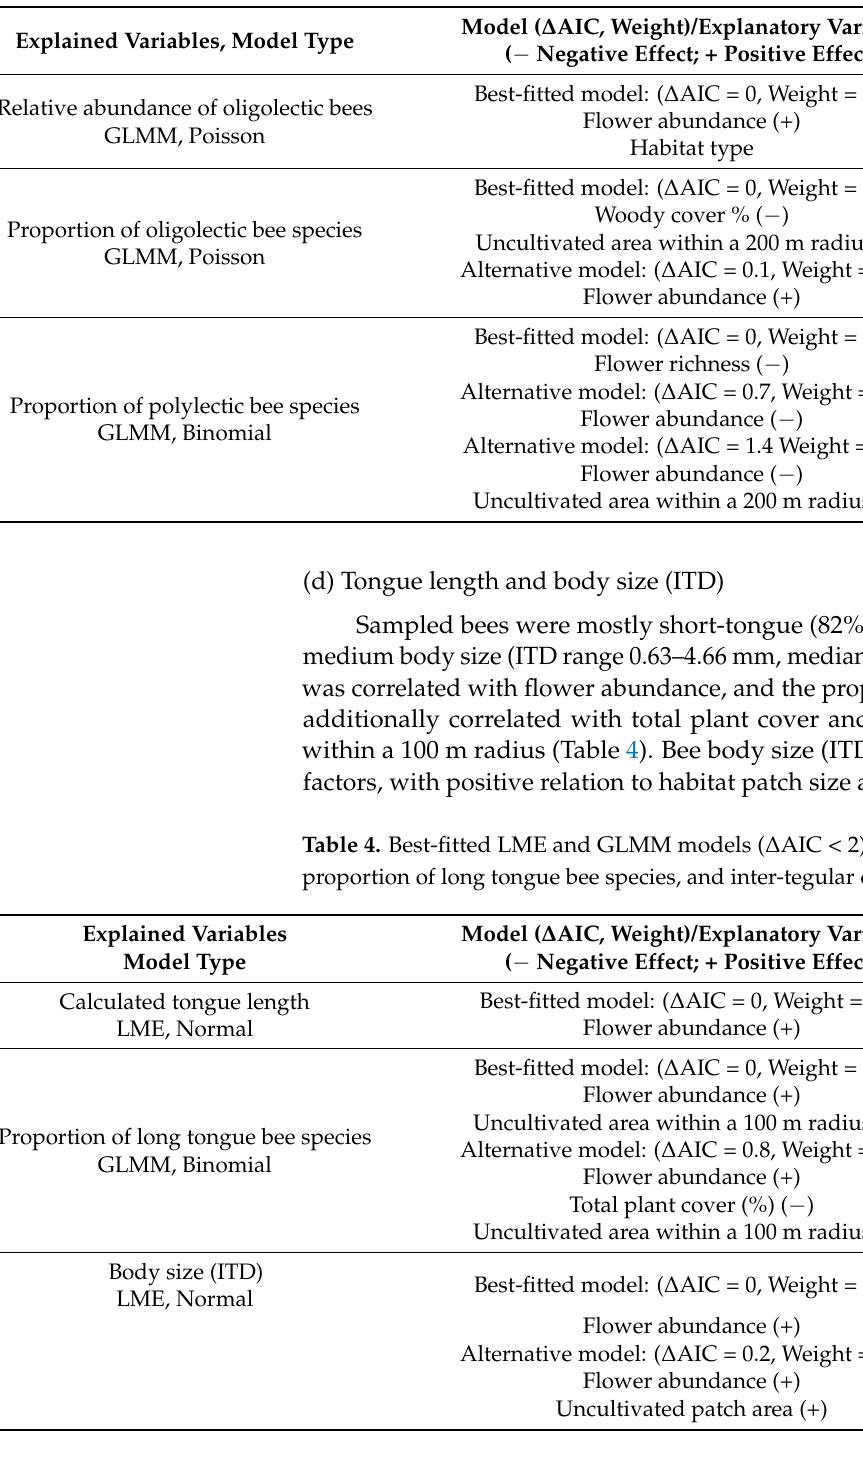
Table 3. Best-fitted GLMM models ( ∆ AIC < 2) for the relative abundance of oligolectic bees, and for the proportion of oligolectic and polylectic bee species.